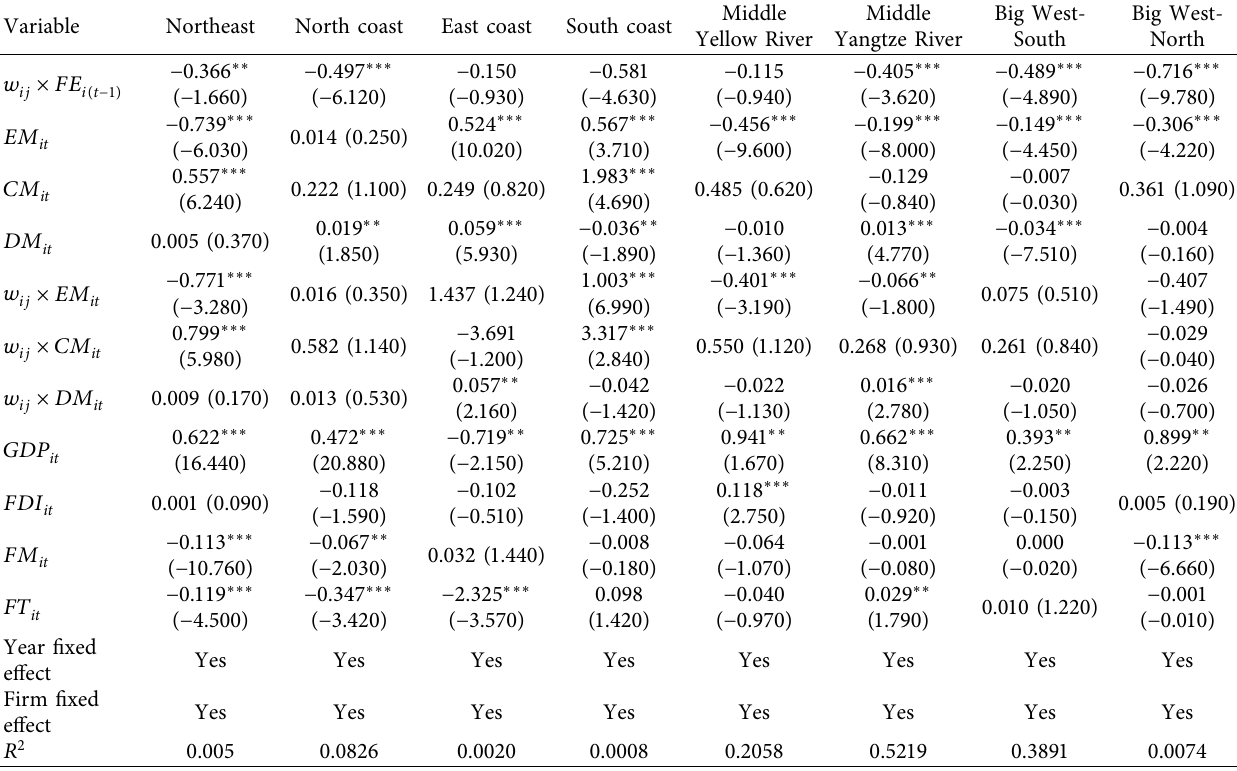
Table 7: Spatial spillover effects of the financial market on regional financial efficiency in the eight economic zones.